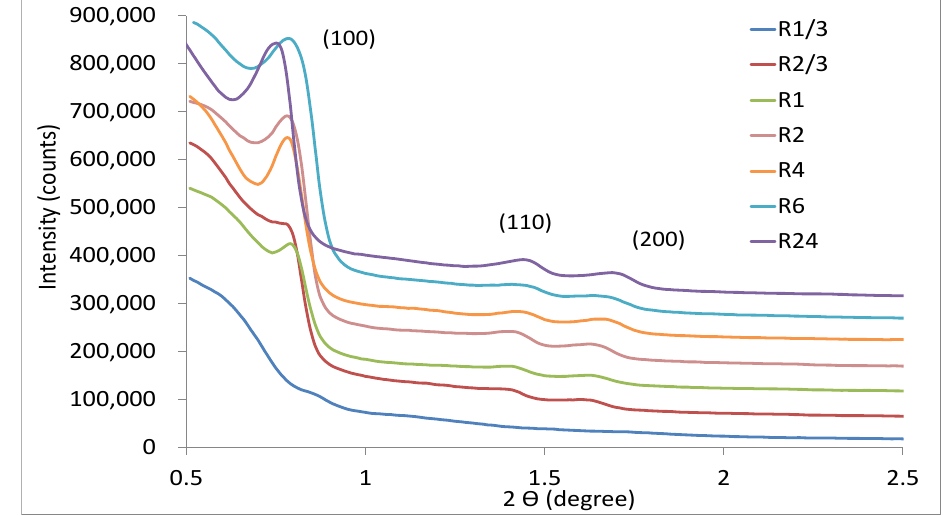
Figure 9. 77K N 2 isotherms of the samples prepared at different reaction times (samples R2/3, R1, R2, R4, R6 and R24 are offset vertically by 100, 200, 300, 400, 500 and 600 cm 3 / STP, respectively).